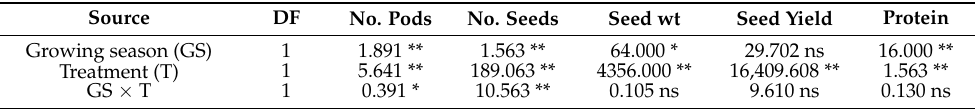
Table 3. Analysis of variance (mean squares) for the seed yield, yield components, and seed protein content of white lupine plants.